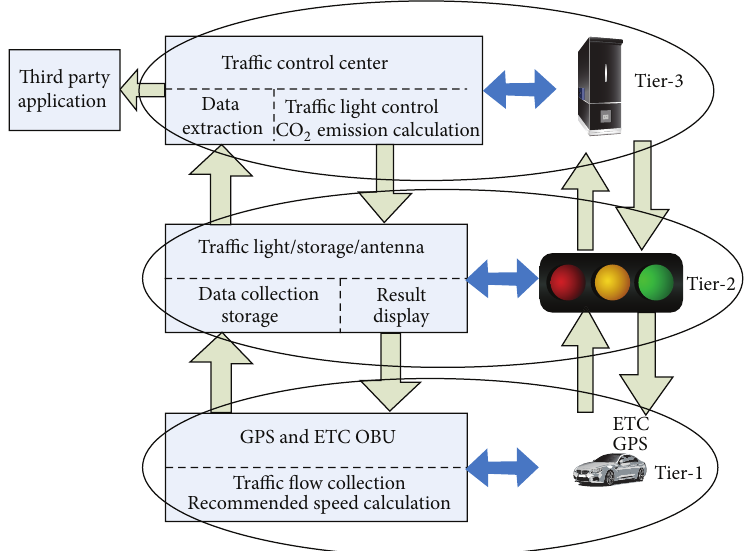
Figure 4: Three-tier open traffic control system.